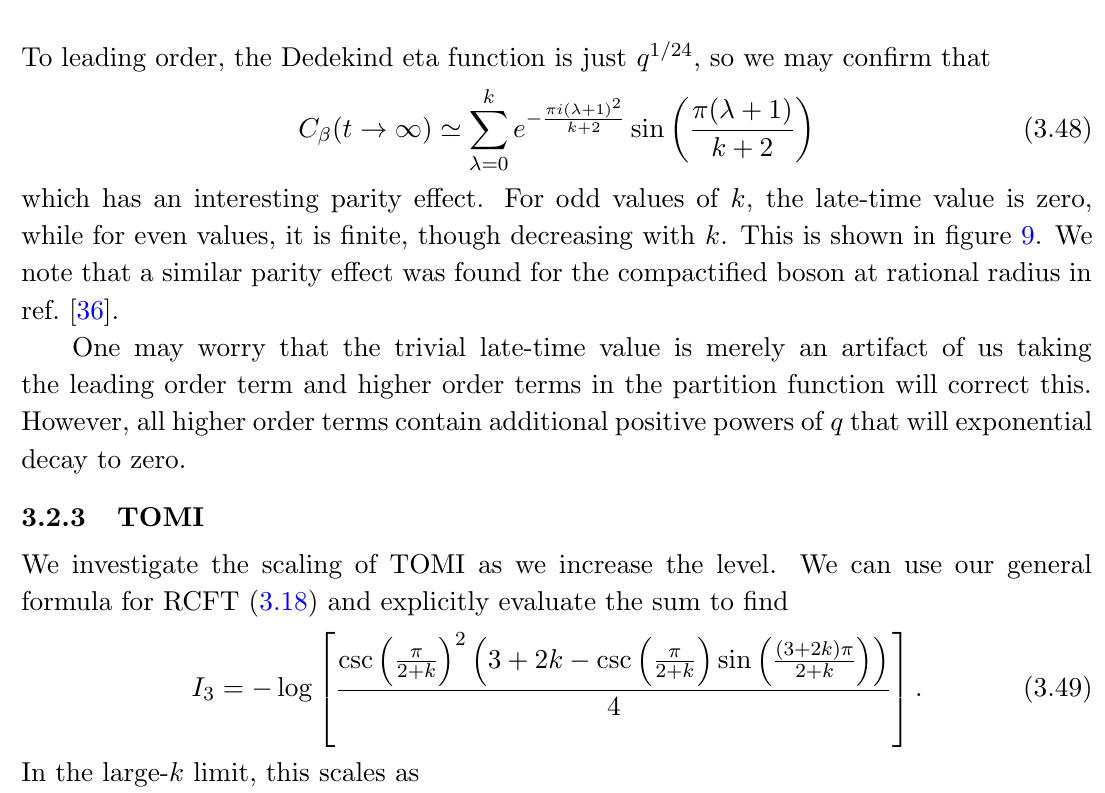
Figure 9 . The absolute value of the OTOC at late times for the su (2) the parity